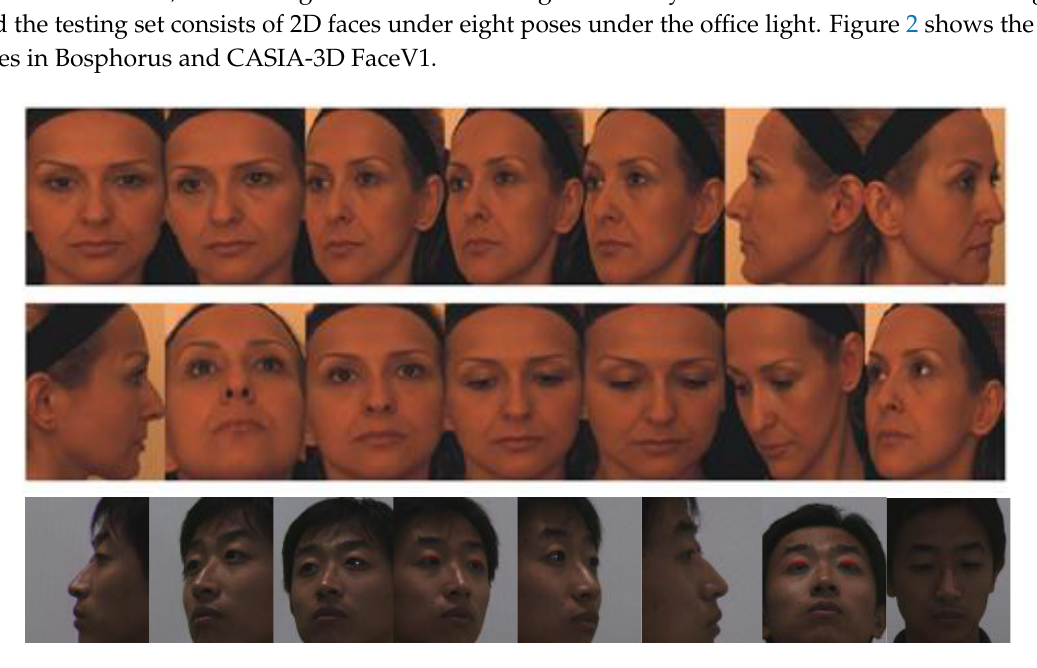
Figure 2. 2D faces in Bosphorus and CASIA-3D FaceV1. In Bosphorus, facial poses of each identity have 7 yaw rotations, ranging from − 90 ◦ to 90 ◦ , 4 pitch rotations, and 2 cross rotations. In CASIA-3D FaceV1, facial poses of each identity have 6 yaw rotations, ranging from − 90 ◦ to 90 ◦ , and 2 pitch